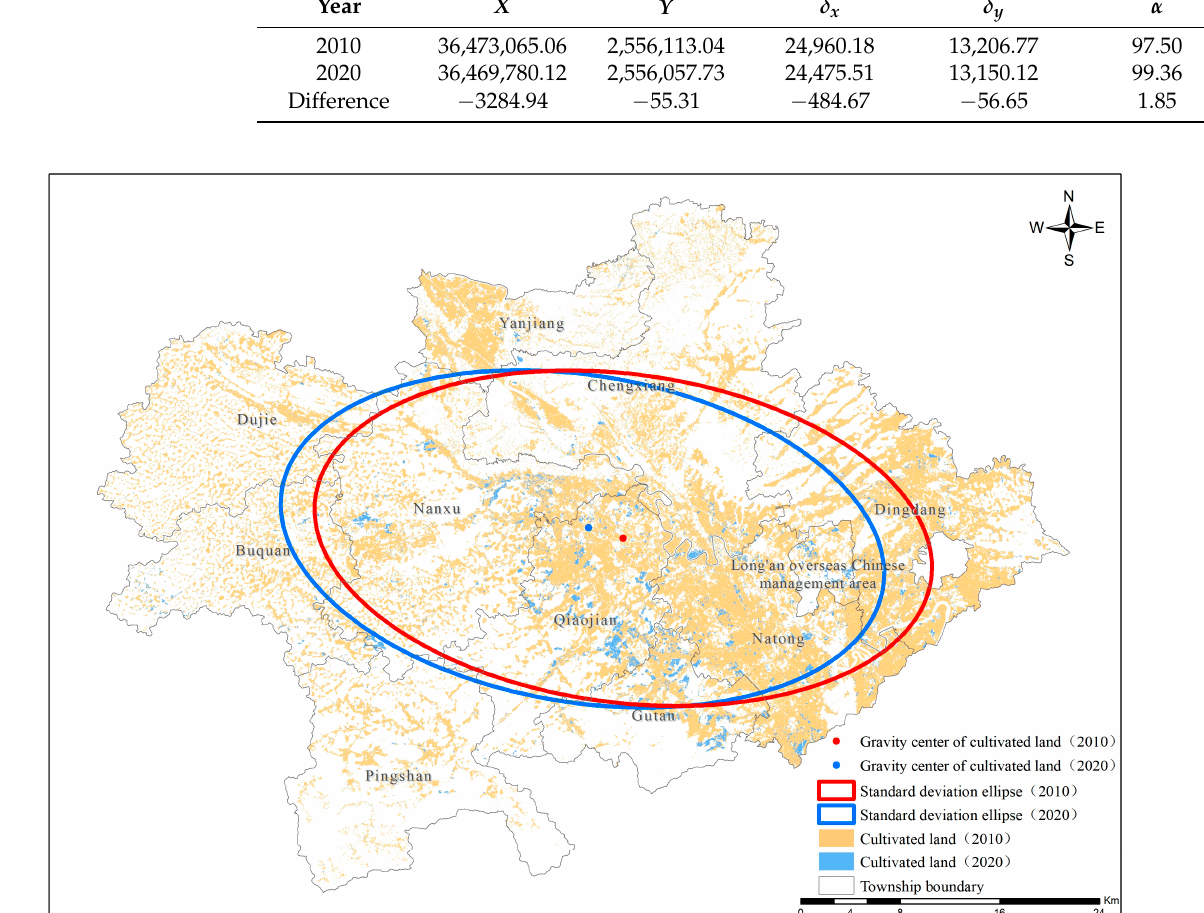
Figure 4. SDEs of cultivated land (2010–2020).